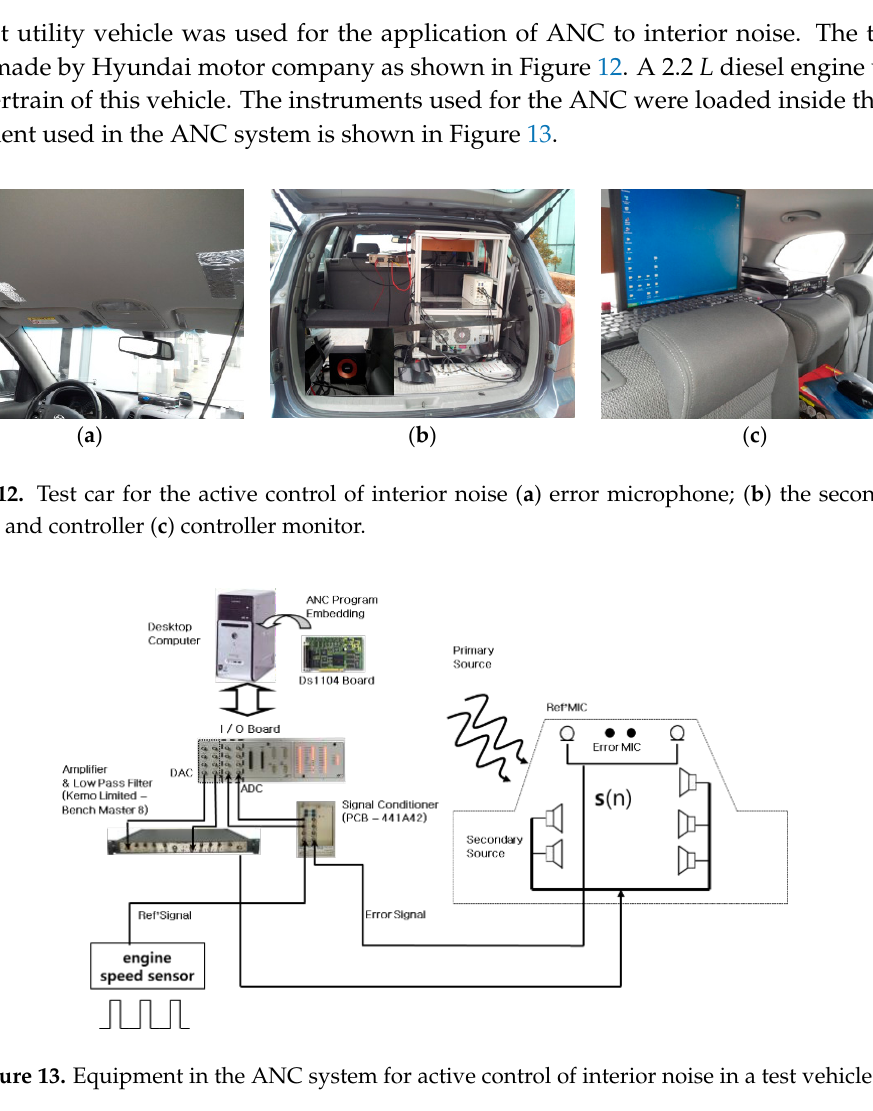
Figure 12. Test car for the active control of interior noise ( a ) error microphone; ( b ) the secondary speaker and controller ( c ) controller monitor.